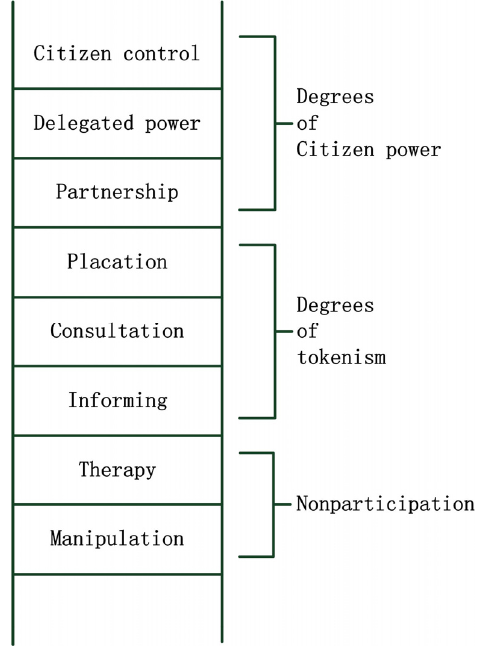
Figure 6. The eight rungs of the Ladder of citizen participation [51].